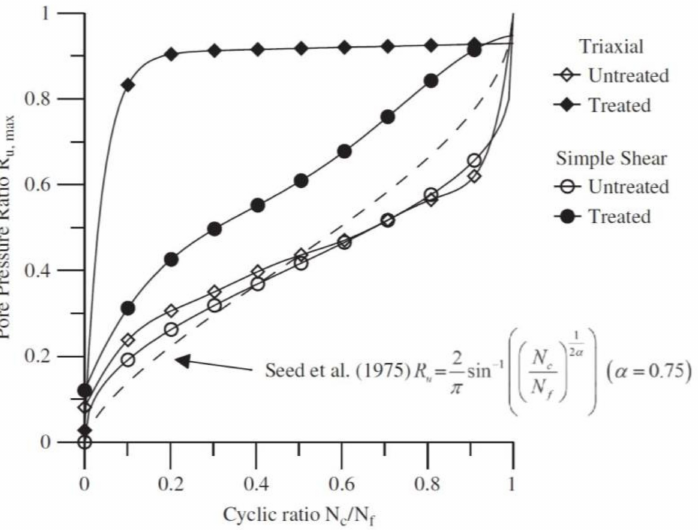
Figure 7. Non-dimensional pore pressure build-up for treated and untreated sand for different loading conditions ([64] with